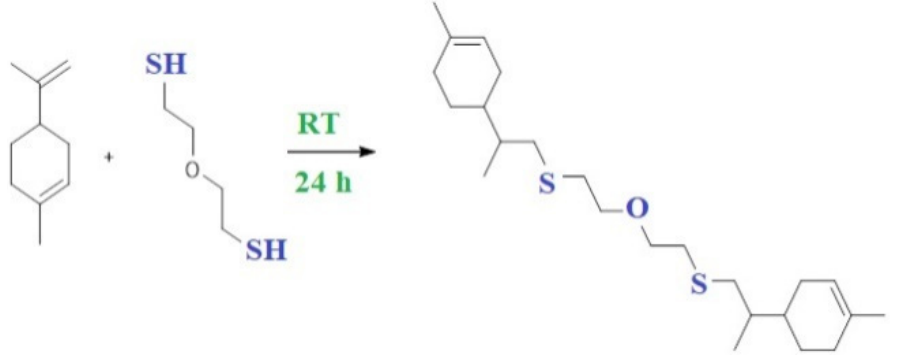
Figure 8. Scheme of addition of mercaptoethyl ether to limonene at room temperature .